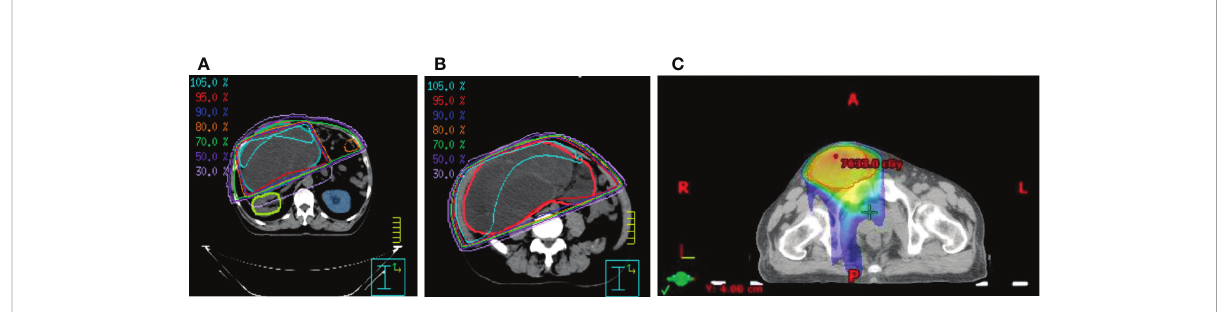
FIGURE 3 The isodose curves that show (A) renal parenchymal sparing and the coverage of the target tumor mass in (B) the peritoneal and (C) the inguinal